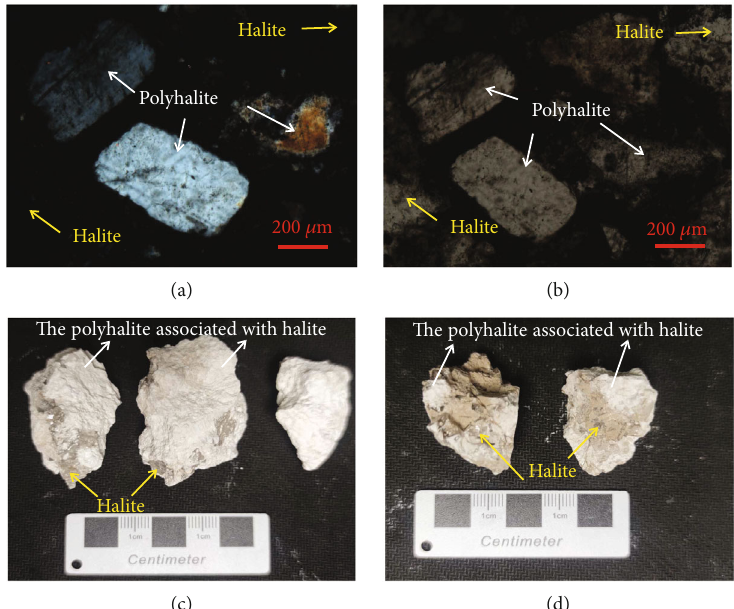
Figure 4: The microscopic morphology of polyhalite in KSL: (a, b) the relationship between polyhalite and halite in the halite layer; (c, d) relationship between polyhalite and halite in the hand specimen (from